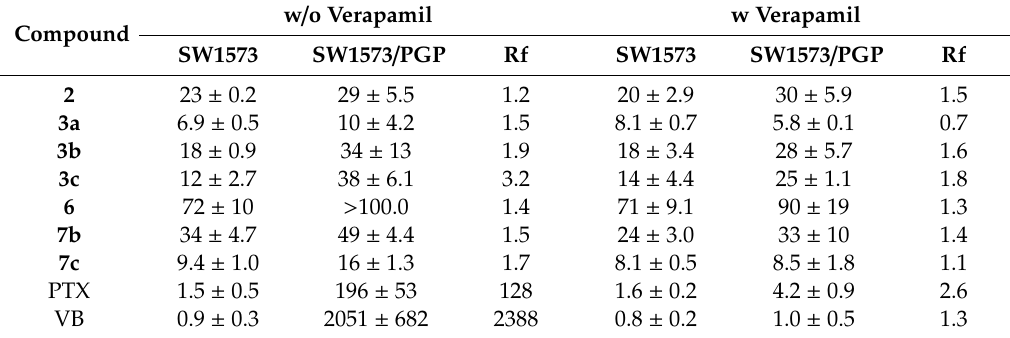
Table 3. Antiproliferative activity (GI 50 ) against SW1573 and SW1573 / PGP cell lines. a